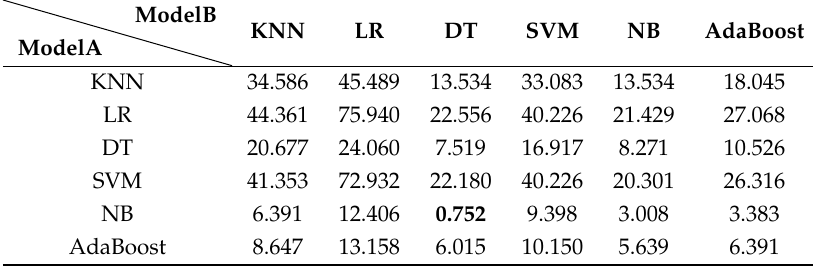
Table 7. The TNR (%) achieved by different combinations of Model A and Model B.